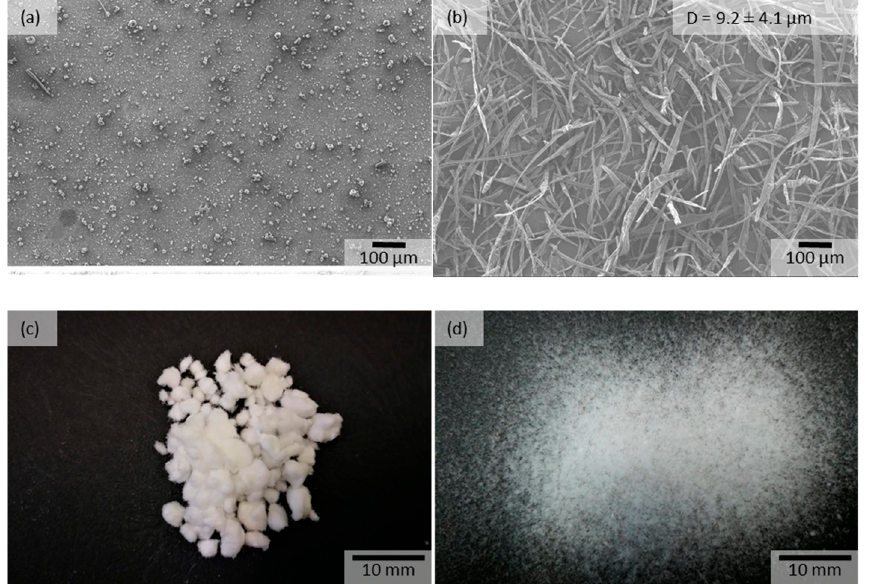
Figure 8. SEM image of the particles obtained from the electrospinning of 40% (HP β CD-50%ASO2) methanol/water (3:1) solution using the ( a ) laboratory-scale HSES equipment with 10,000 rpm, 40 kV, and 20 mL/h, and the ( b ) pilot-scale HSES equipment with 40,000 rpm, 40 kV, and 100 mL/h. Photo of the fibers ( c ) before and ( d ) after sieving (only tapping).